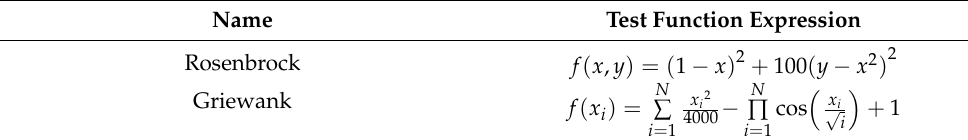
Table 2. Test functions to test the performance of the adaptive PSO algorithm.